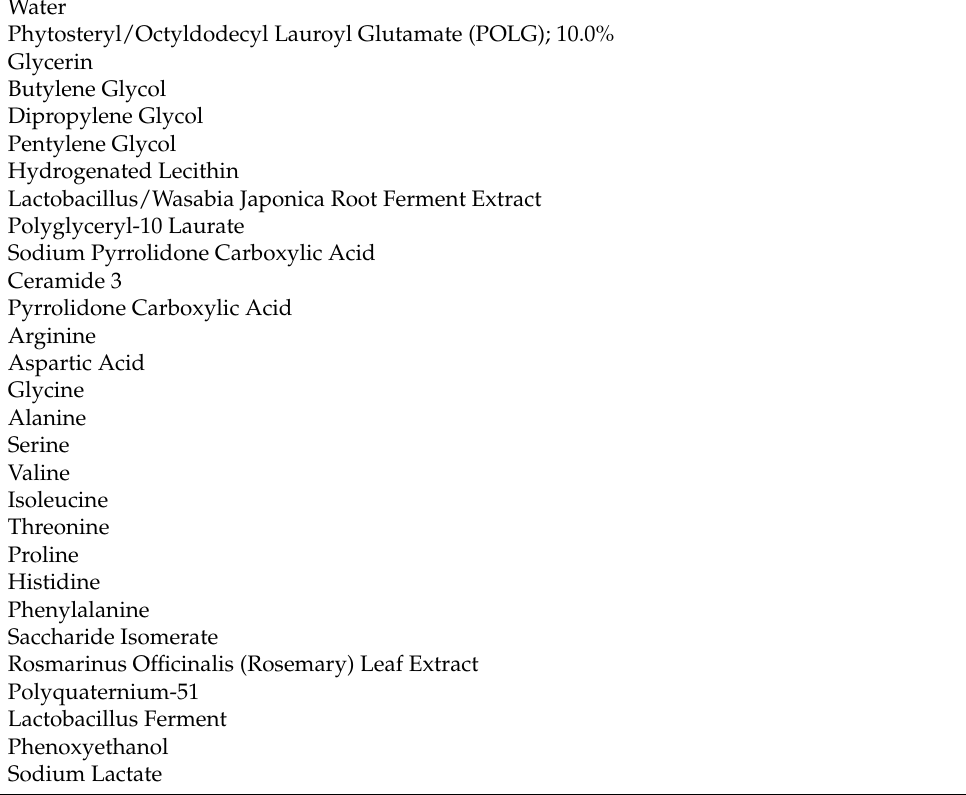
Table 1. Components of the POLG nano-emulsion